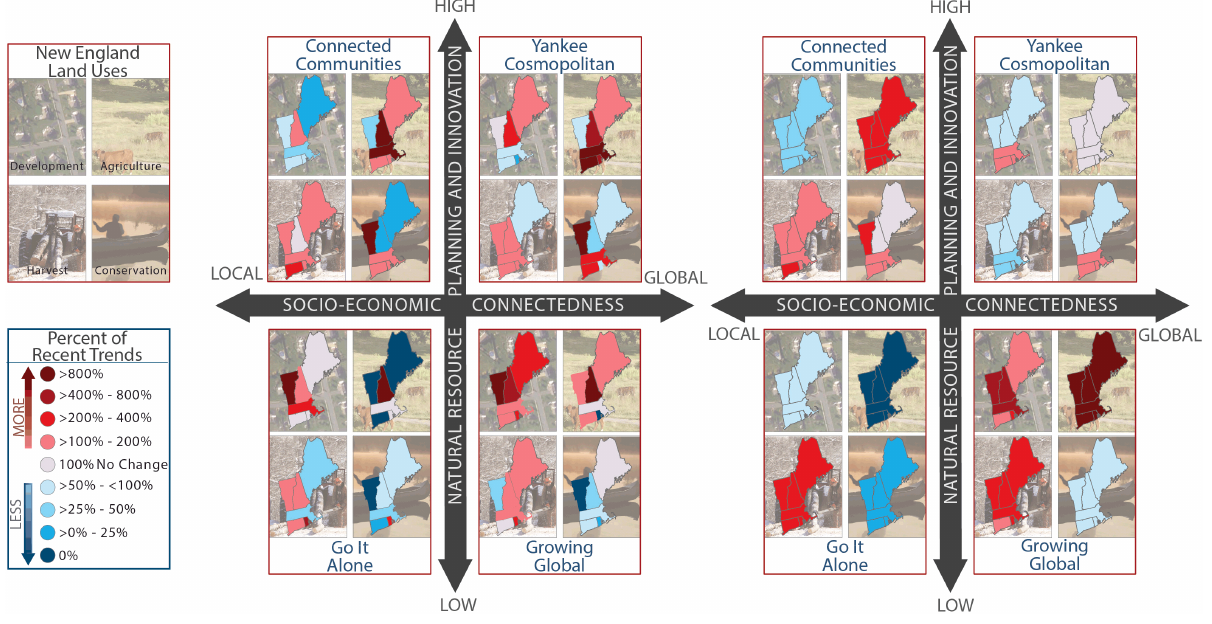
Fig. 4 . (a) Original stakeholder estimates, and (b) adjusted rates of land-use change for each state in New England as a proportion of recent